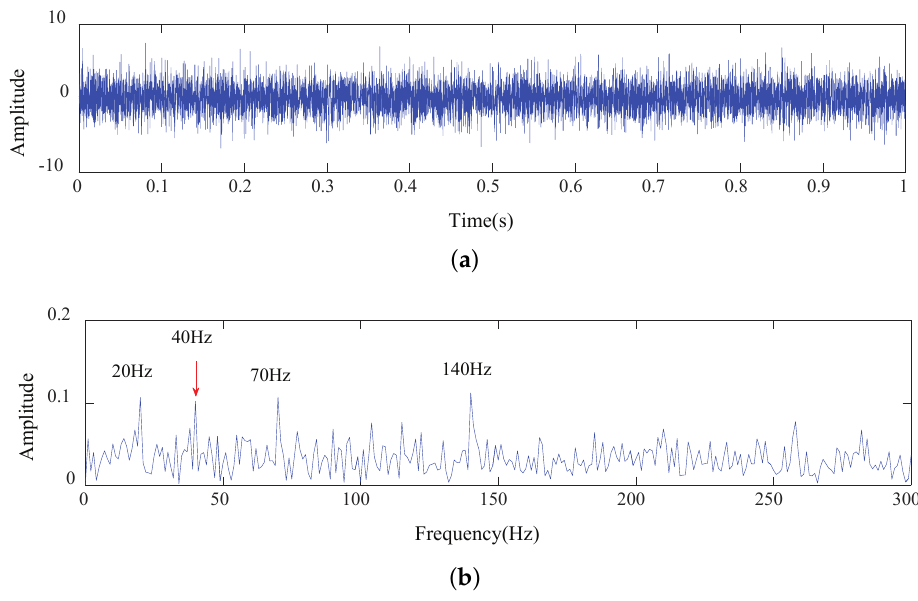
Figure 11. Results of soft threshold: ( a ) Time-domain waveform. ( b ) Frequency